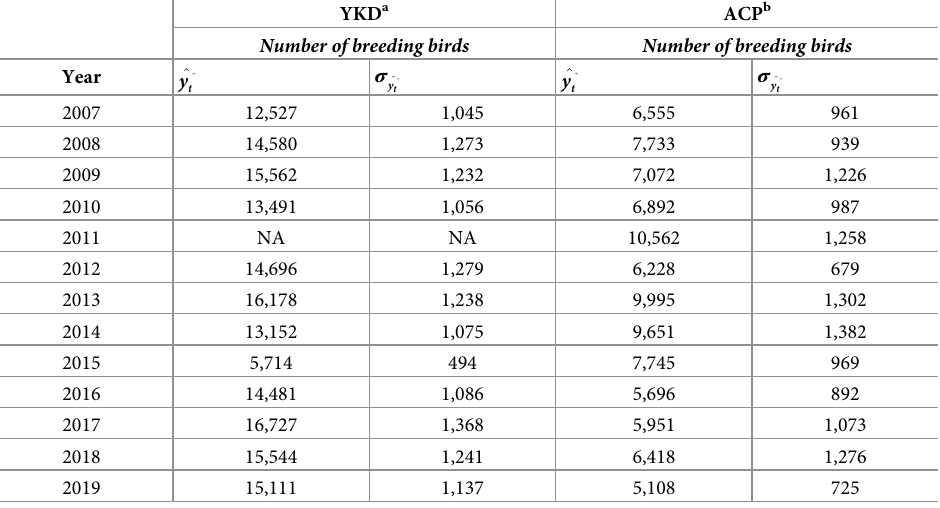
There were no surveys flown in 2011 and thus no estimates are provided. a YKD metrics refer to the Yukon-Kuskokwim Delta breeding population. b ACP metrics refer to the Arctic Coastal Plain breeding